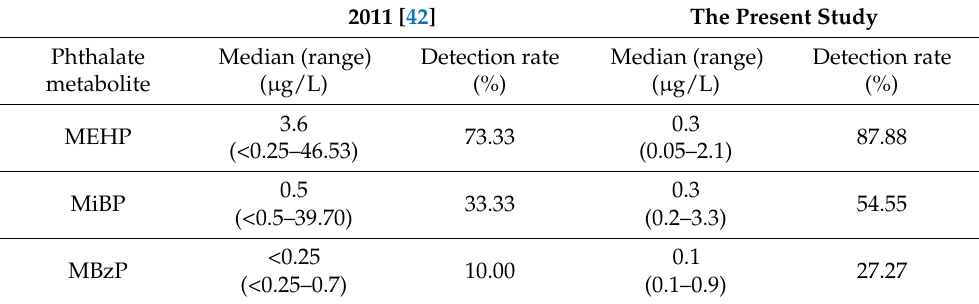
Table 5. Comparison of phthalate metabolite levels in human breast